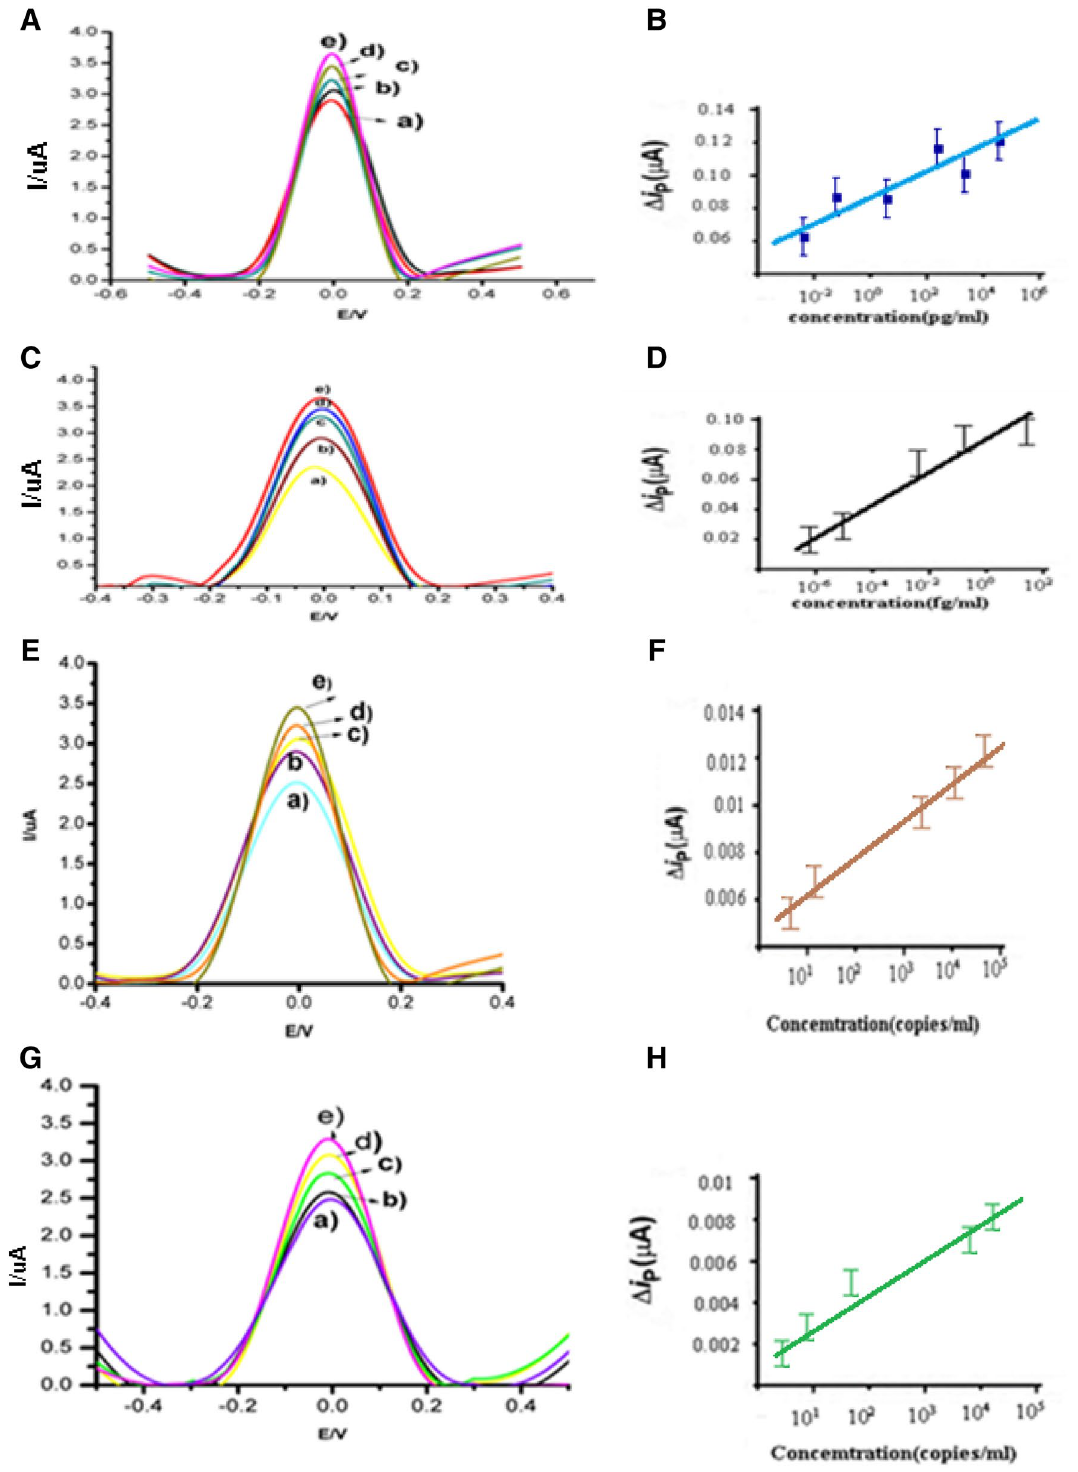
Figure 5. The performance of the sensor for screening and specific detection of SARS-CoV-2 in vitro and clinical samples using DPV measured at a scan rate 50 mV s −1 in phosphate buffer (pH 7.4). ( A ) Screening of SARS-CoV-2 Antigen based on DPV images using the 1 µg/mL (e) to 500 fg/mL (a) on the MV-gal1/SCPE-GNP in vitro. ( B ) A calibration plot of the current density vs log concentration of SARS-CoV-2 Antigen. ( C ) Specific detection of SARS-CoV-2 Antigen based on DPV images using the 1 1 fg/mL (e) to 250 pg/mL. ( D ) A calibration plot of the current density vs log concentration of SARS-CoV-2 Antigen, in vitro. ( E ) SARS-CoV-2 Virus screening from clinical samples based on DPV. ( F ) A calibration plot of the current density vs log concentration of SARS-CoV-2 virus (copies/mL). ( G ) Detection of specific SARS-CoV-2 Virus from clinical samples based on DPV. ( H ) A calibration plot of the current density vs log concentration of SARS-CoV-2 virus